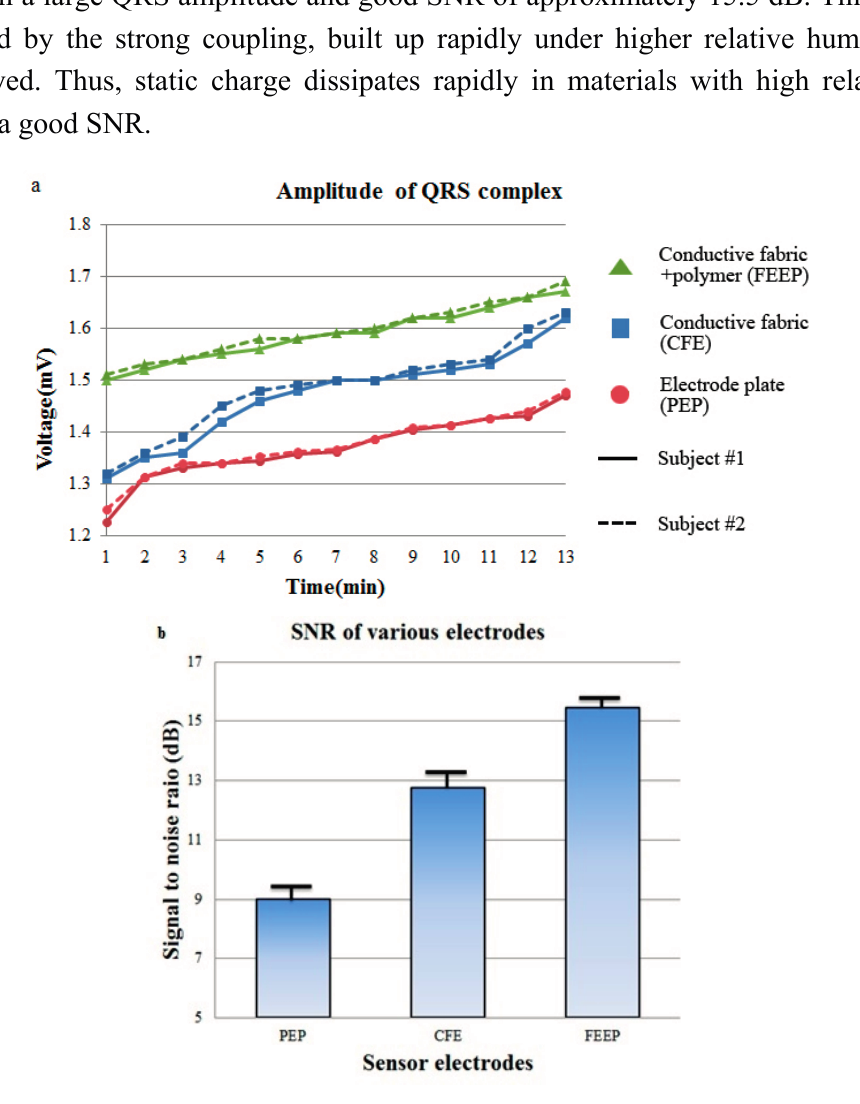
Figure 5. Performance analysis of the monitoring system. ( a ) Amplitudes of QRS complexes for each sensor electrodes tested on two subjects; ( b ) Means and standard deviations of the SNRs for each sensor